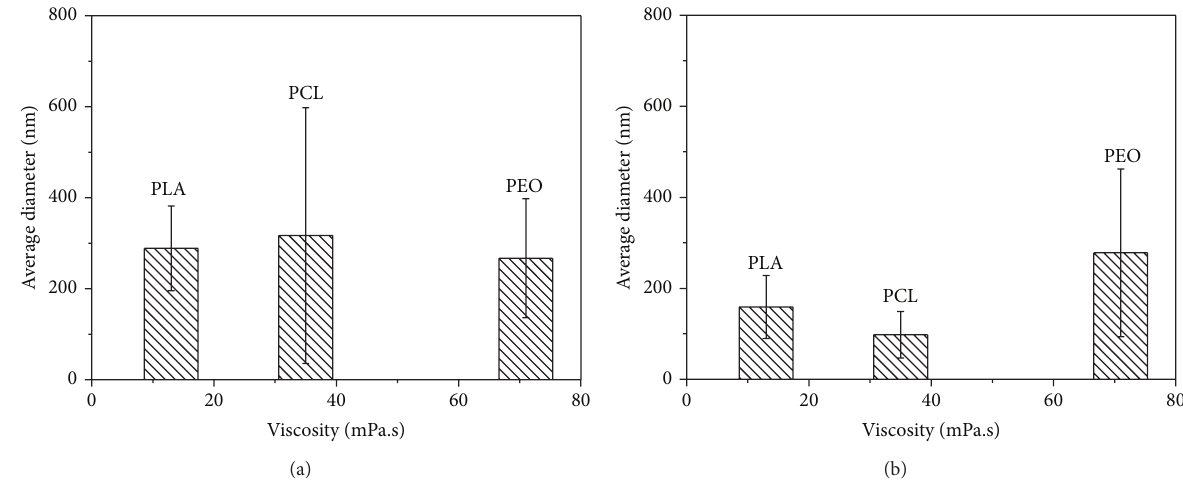
Figure 3: Effect of viscosity on fiber diameter and dispersion by (a) solution blow spinning and (b) electrospinning.